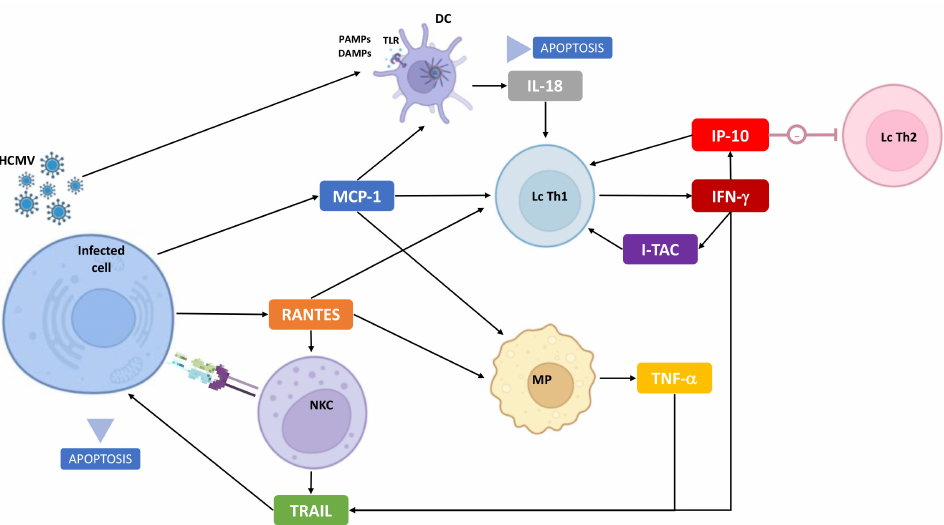
Figure 4. Immunobiology of cCMV: focus on cytokines identified in this study and interactions with infected and immune cells. NKC: natural-killer cell, MP: macrophage, Lc Th1: T-cell involved in Th1 immune response, Lc Th2: T-cell involved in Th2 immune response, DC: dendritic cell, TLR: Toll-like receptor, PAMPS/DAMPs: pathogen-associated molecular patterns/damage-associated molecular